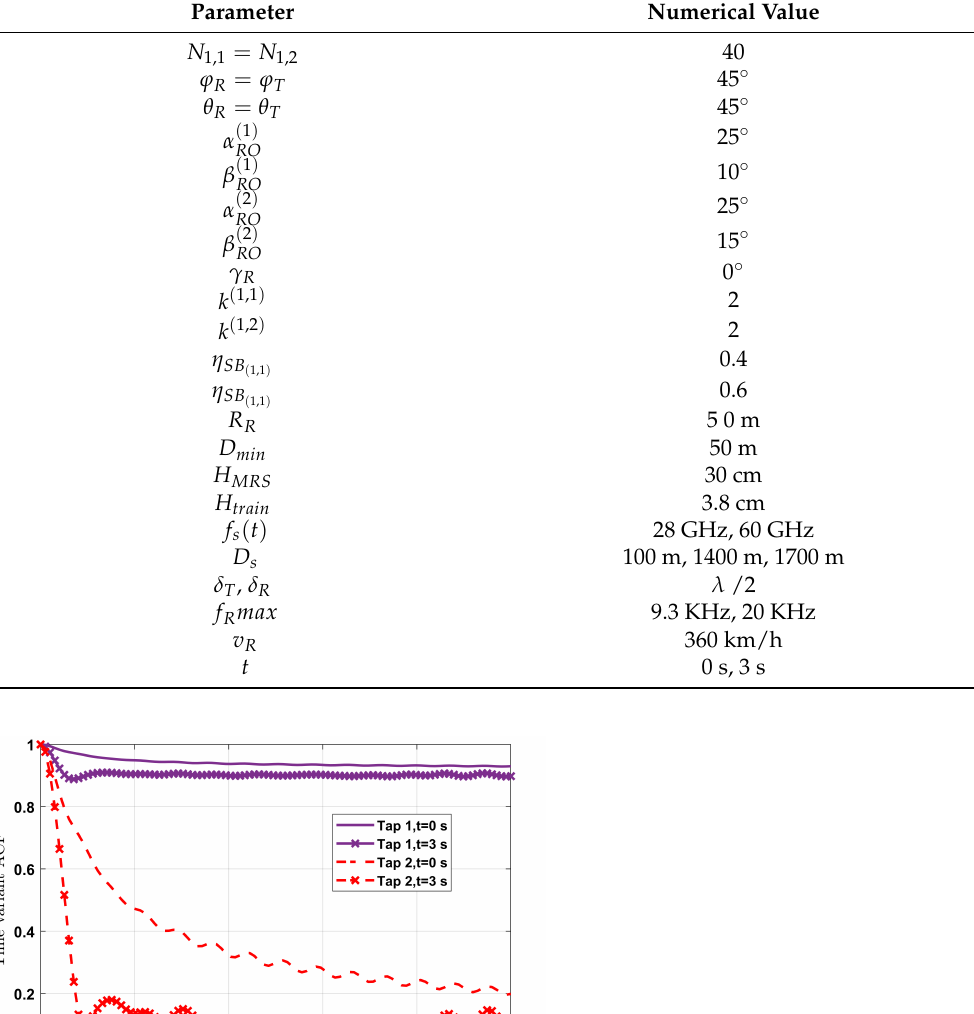
Table 2. Numerical values used for the simulation model.